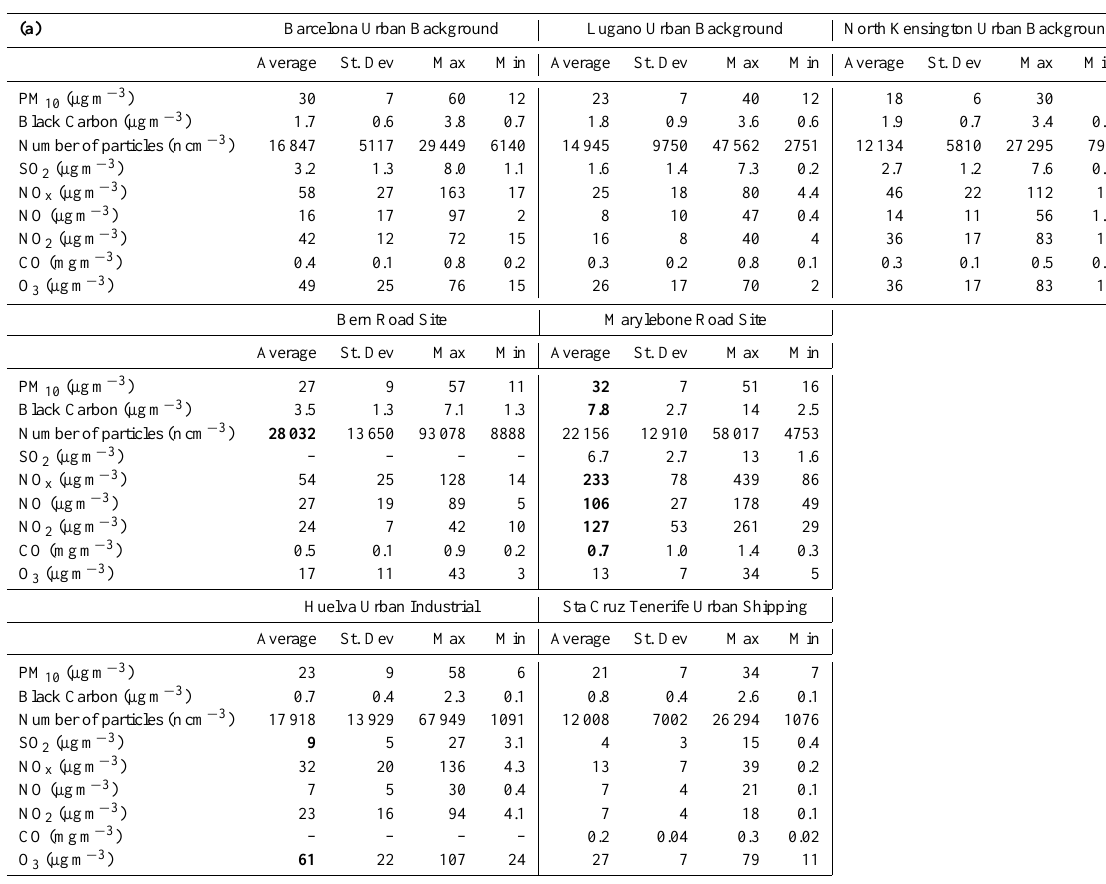
Table 4. Average values of the main parameters measured in each site under study: (a) average, maximum and minimum concentrations of atmospheric pollutants (b) vehicle fleet information and ratios of atmospheric pollutants in the units derived from those in (a). Maximum values between stations are in